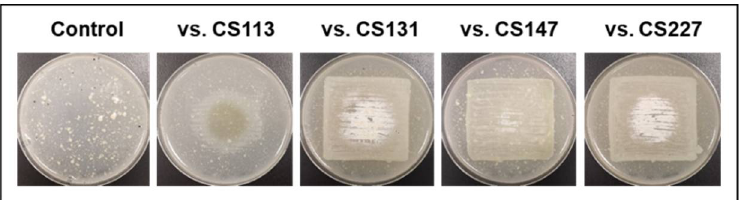
Figure 2. Strain CS194 grown in SFM medium paired with different CS strains in VOC